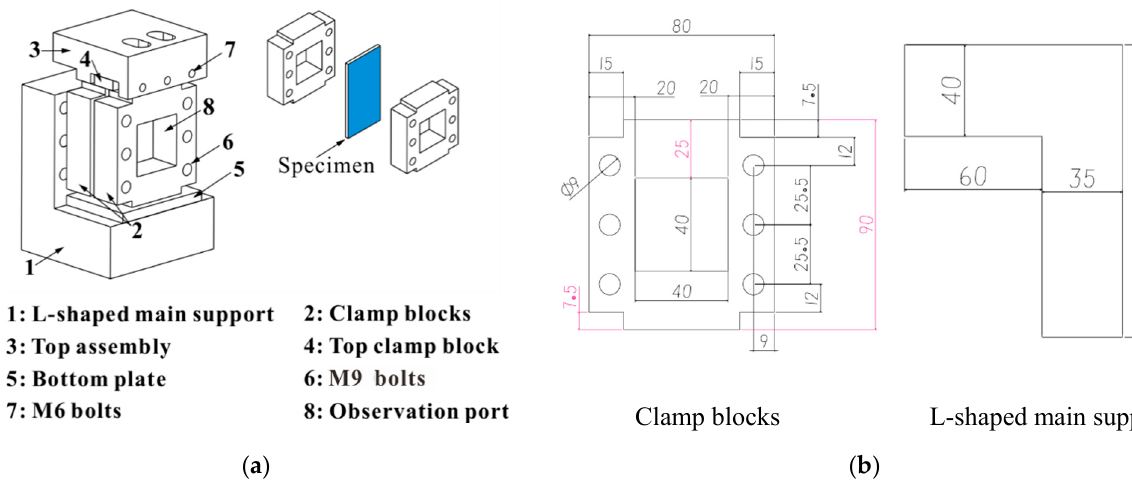
Figure 2. ( a ) The schematic diagram of the compression fixture and ( b ) main dimension parameters of the fixture.